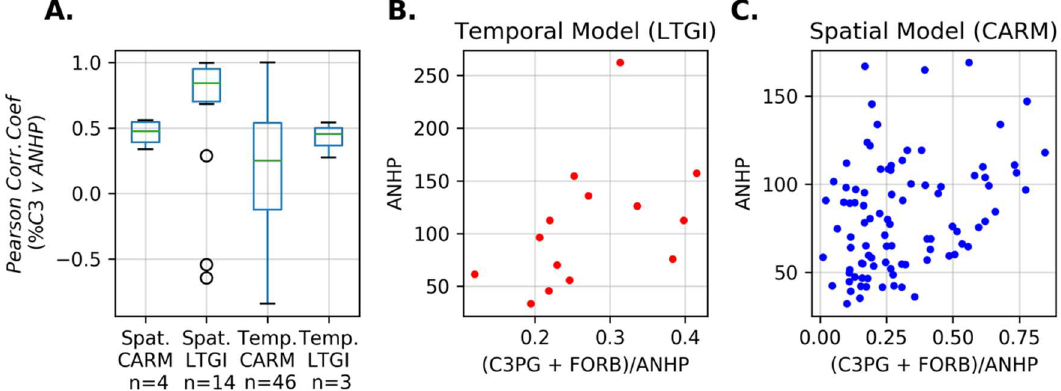
Figure 8. The relationship between the relative abundance of C3PG to ANHP. ( a ) Box plots of the Pearson correlation coefficient for the CARM and LTGI, spatial and temporal models. ( b , c ) Examples for a LTGI temporal model (Pasture = 15E, moderately grazed) and CARM spatial model (Year = 2013), respectively.